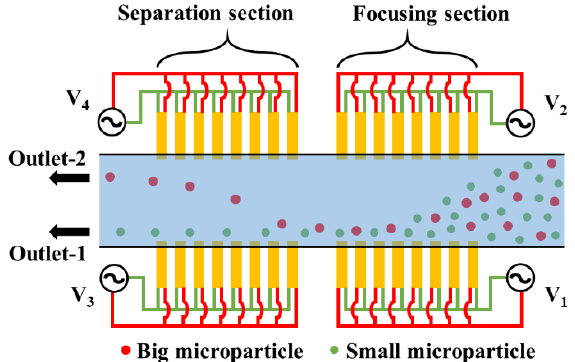
Figure 3. Schematic of the working of the device (top view); in the focusing section, the heterogeneous mixture is subjected to negative dielectrophoresis (nDEP) forces from both the electrode pairs, leading to their focusing near one set of the electrode pairs, whereas, in the separation section, the big microparticles are subjected to nDEP forces leading to them being pushed into the interior of the microchannel while the small microparticles do not experience DEP, leaving their position unaffected; V 1 < V 2 , V 3 > V 4 , N 1 = N 2 >> N cr , N 3 = N 4 = N cr,sp.